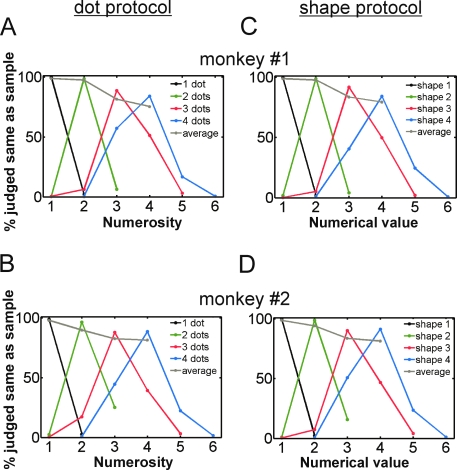
Behavioral Performance(A and B) Dot protocol.(C and D) Shape protocol.The curves show how often the monkeys judged the first test and sample numerosity to be equal. The numerical value in the first test display is shown on the x-axis. Each color stands for a certain numerosity shown during the sample period. Average performance for each numerosity is shown in gray as percentage correct (chance level = 50%).